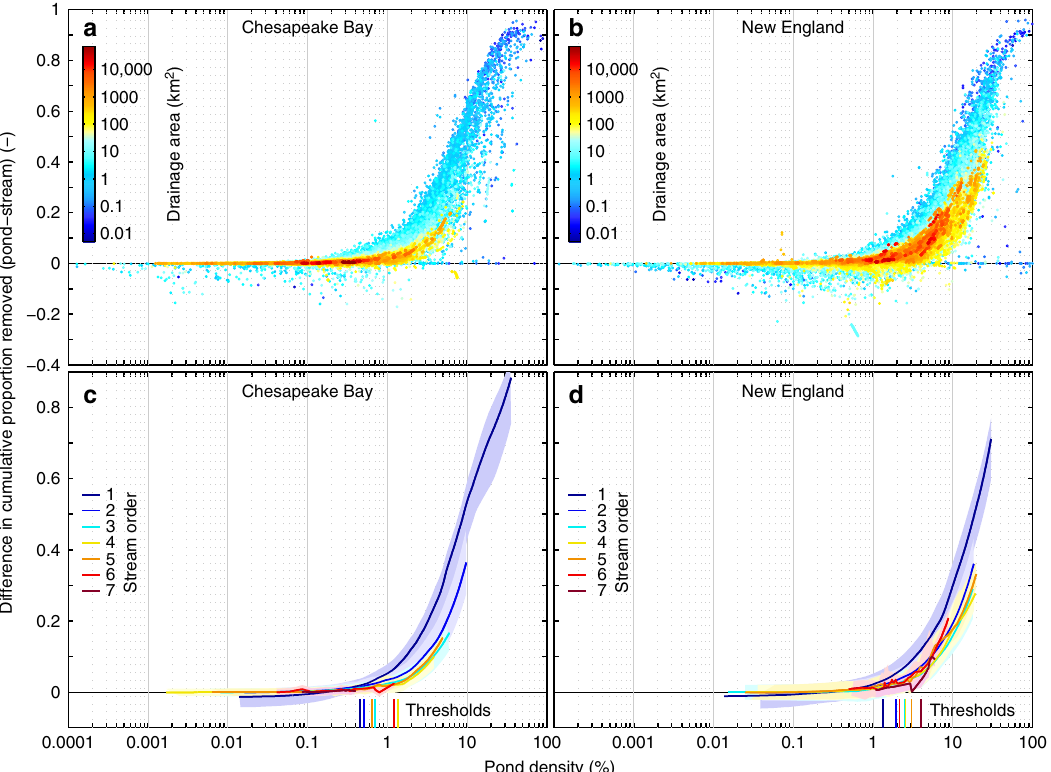
Fig. 2 Cumulative proportion of total nitrogen removed annually by ponded waters relative to streams (expressed as a difference) for varying pond densities and network locations. Dot-plots are colored by cumulative upstream drainage area for the a Chesapeake Bay and b New England sub-regions (see Fig. 1). A locally weighted scatterplot smoothing was applied to the values per stream order to identify pond density thresholds for the c Chesapeake Bay and d New England sub-regions (see Methods). Shaded regions are the upper and lower limits of the scatterplot